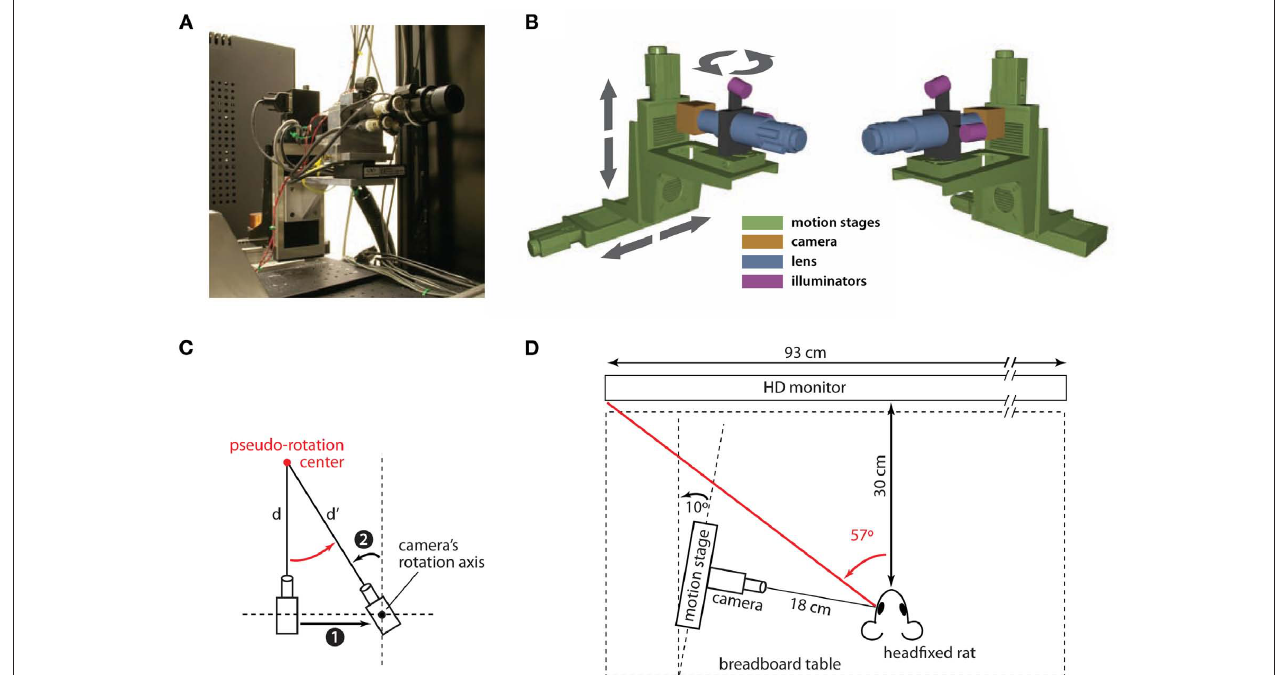
camera assembly) illustrates how a horizontal translation of the camera to the right (1) can be combined with a left rotation of the camera about its rotation axis (2) to achieve a pseudo-rotation (red arrow) about a point (red circle) at an arbitrary distance d from the camera itself. This drawing also illustrates how, following the pseudo-rotation, the distance between the camera and the center of the pseudo-rotation changes from d to d ′ . (D) Diagram showing the position of the camera assembly relative to the imaged eye of the head-fixed rat. The distance of the animal from the screen used for stimulus presentation and the amplitude of the rat’s left visual hemifield are also